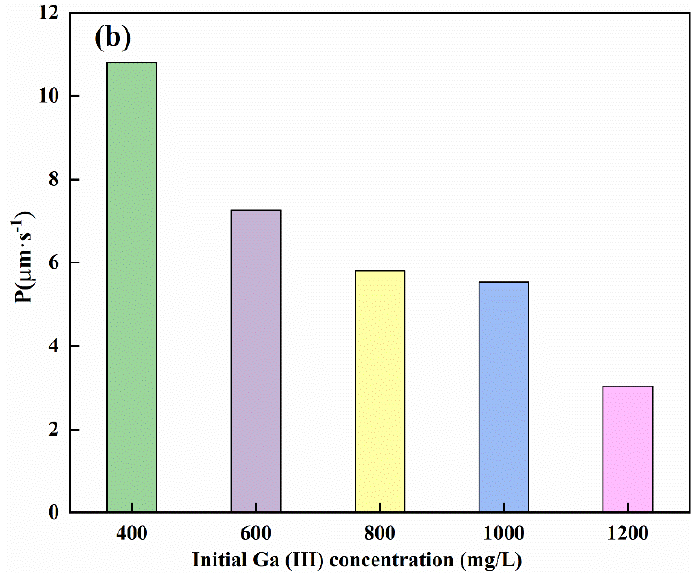
Figure 7. Effect of Ga(III) concentration in feed solution on the transport of Ga(III) by SLMs , ( a ) Extraction percentage, ( b ) permeability coefficient (Acidity: 6 M HCl; Carrier = 0.5 M R 4 NCy, Strip: pH = 1).